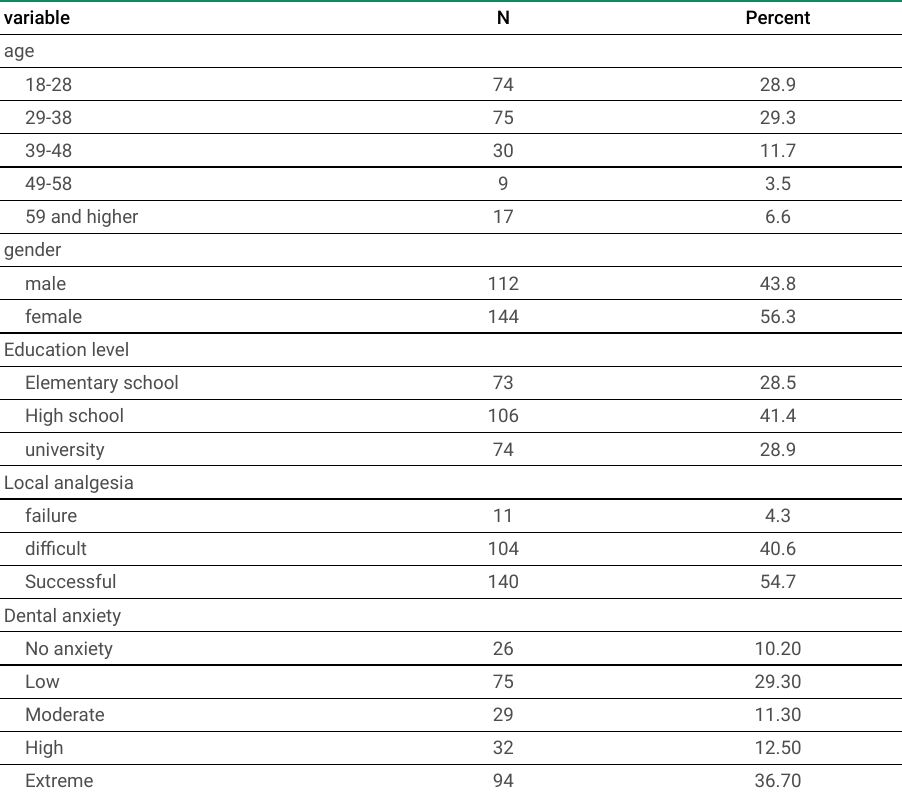
Table 1. The number and percent of research variables